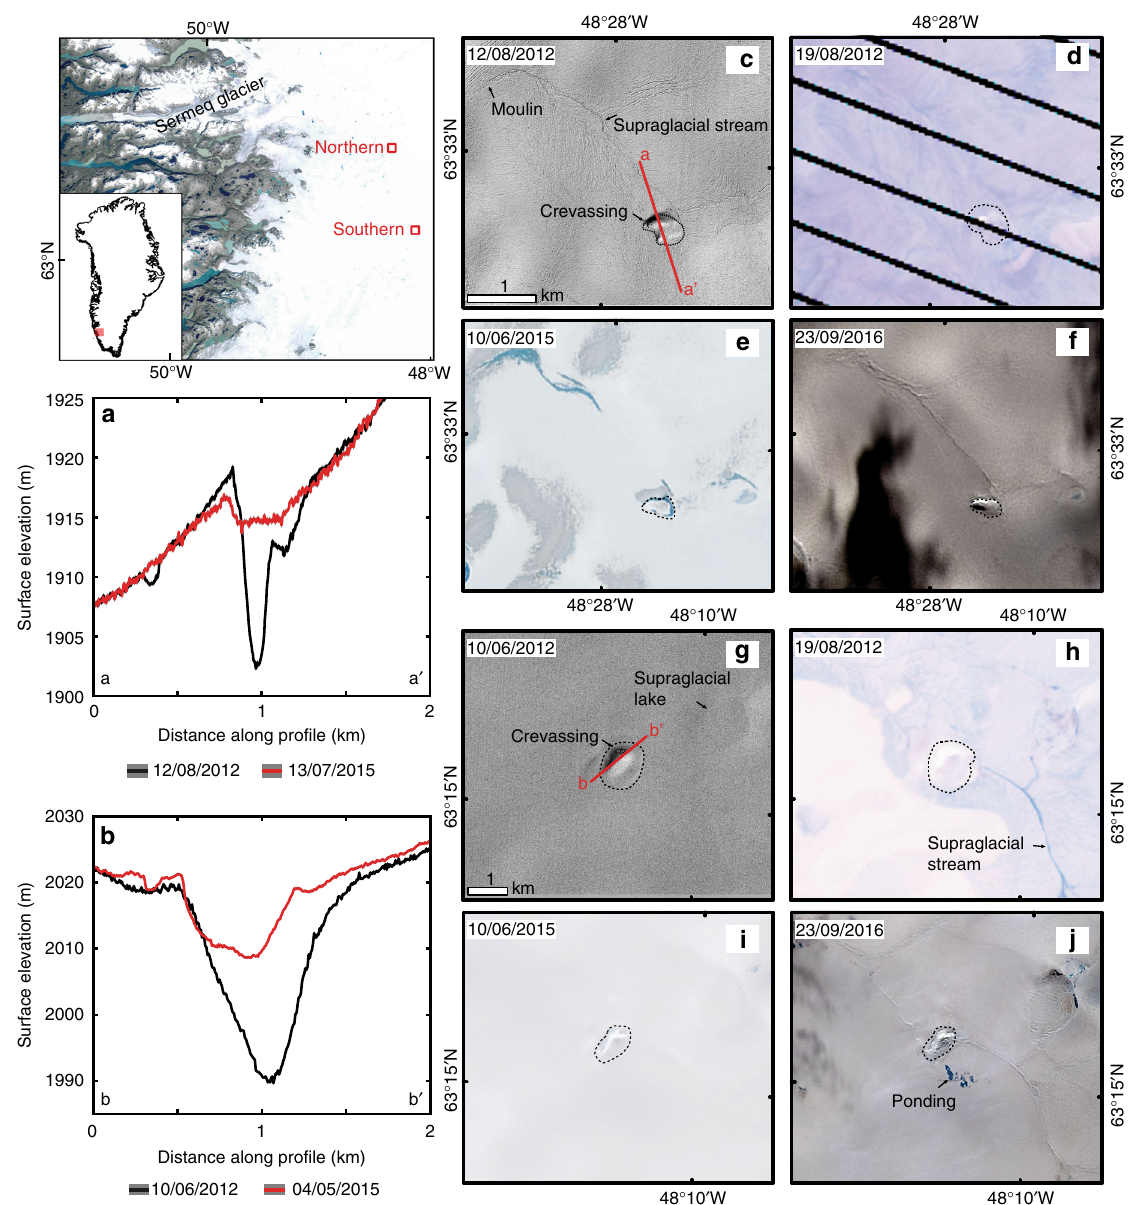
Fig. 2 Surface elevation change and evolution of active subglacial lakes in southwest Greenland. Inset map shows location of collapse basins near Sermeq glacier. a Surface elevation pro fi le across fl ow at northern collapse basin, measured using the ArcticDEM 2 m resolution strip fi les. ±0.2 m error bars are shown. b Surface elevation change along fl ow at southern collapse basin. Hillshades of the ArcticDEM and Landsat 4, 5, 6, 7 imagery showing evolution of collapse basins from depression to dome-like features through continued uplift between 2012 and 2016 for north basin ( c – h ) and south basin ( g – j ), indicating subglacial lake drainage events. Source data are provided as a Source Data fi